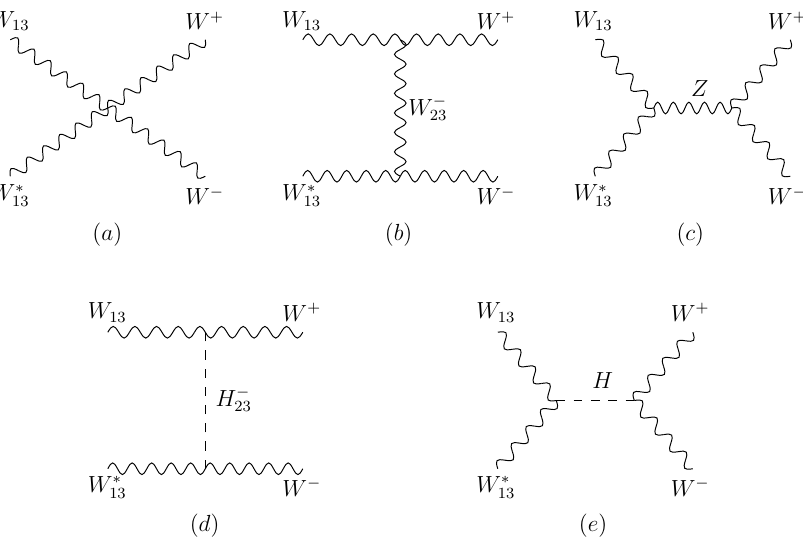
Figure 1 . Dominant contributions to the process W charged wrong Higgs (cid:12)eld combined of ’ (cid:0) to H (cid:0) is the Goldstone boson eaten by W (cid:0) 23